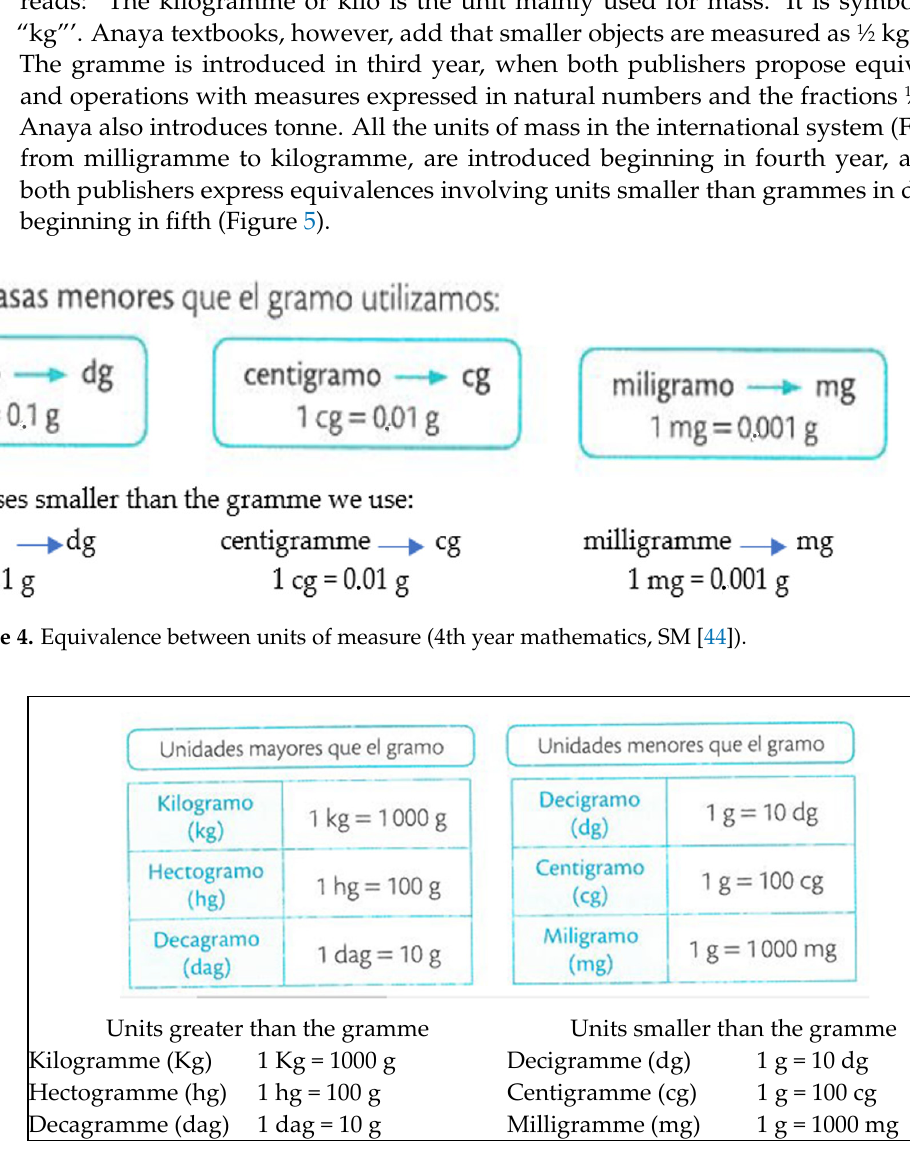
Figure 6. Unit of measure conversion (fourth year mathematics, SM [44]). In mathematics both publishers use standard (m 3 , cm 3 ) and non-standard (cube of unknown dimensions) cubic units for measuring volume directly, while explaining the equivalence between multiples and sub-multiples of the cubic centimetre. That strategy, in which the number of unit cubes that can be iterated across the object is counted, is only useful for calculating the volume of cube-shaped figures. The science books, on the con- trary, use graduated containers to calculate the volume of liquids and any solid object, irrespective of shape. The SM books furnish a full description of how to calculate the vol- ume of liquid displaced in litres or millilitres when an object is completely submerged in a graduated container. Anaya explains that method as well, while also instructing earlier year students to build a mould of the object and measure its capacity to establish the rela- tionship between the two magnitudes (Figure 7). This publisher deploys different units of measure (L, ml, m 3 , cm 3 ) depending on the year of schooling, but fails to establish how they are related. That relationship is set out in the mathematics books. Nonetheless, whilst the Anaya products contend that “capacity and volume are equivalent magnitudes” SM distin- guishes between “volume as the space occupied” and “capacity as the space enclosed by